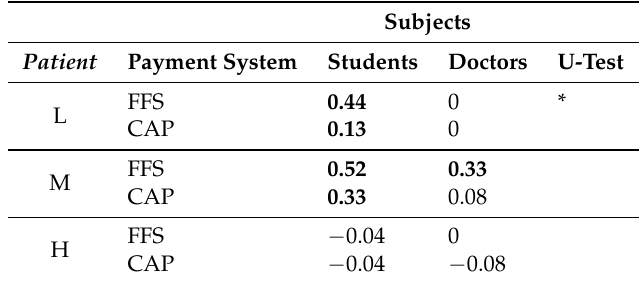
Table A3. Misreporting between student and medical doctor